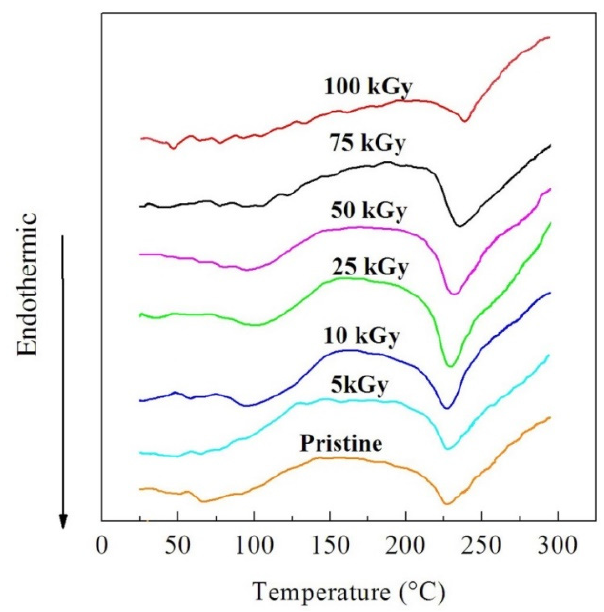
Figure 5. DTA thermograms of the pristine and irradiated NC films.